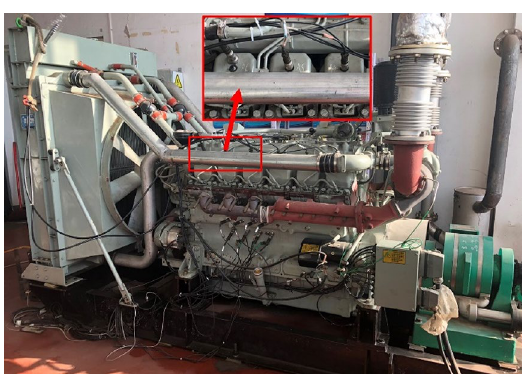
Figure 13 Diesel engine and measuring point